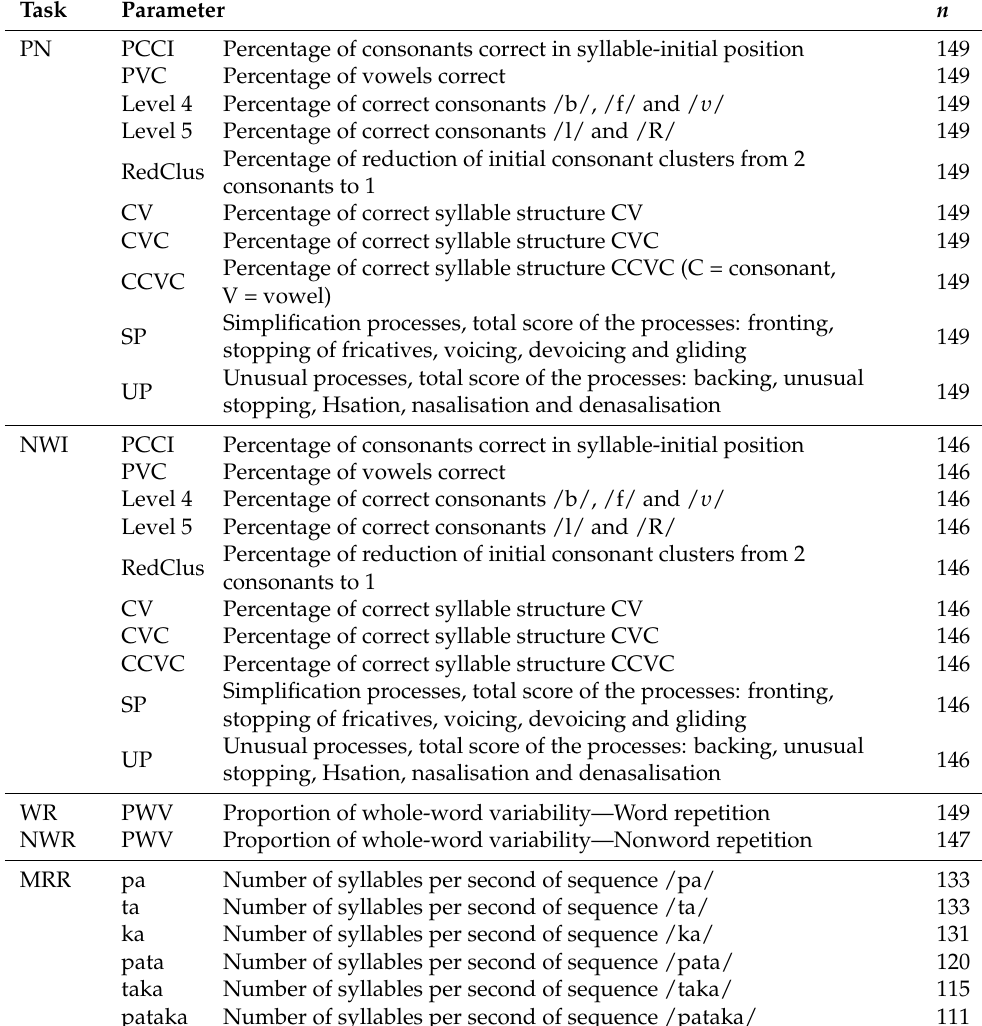
Table 1. Parameters/outcome measures per speech